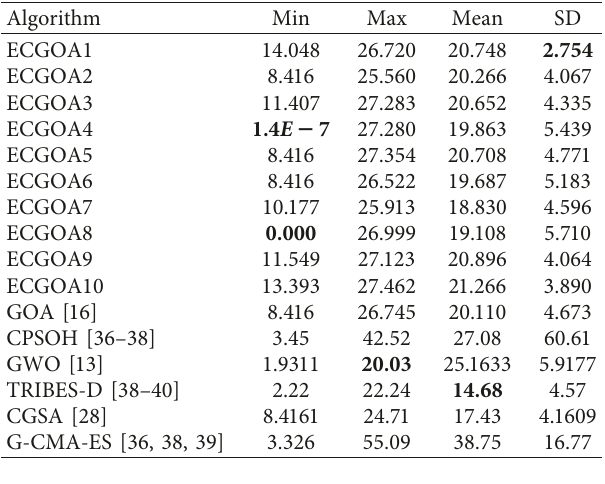
Table 10: Error in objective function values for frequency-mod- ulated sound waves synthesis